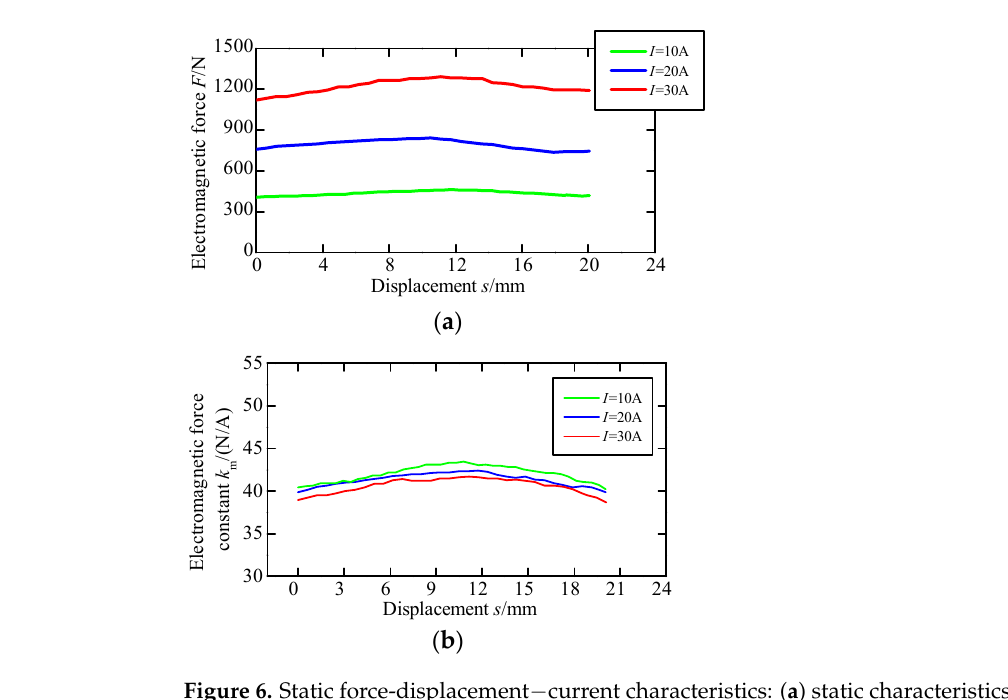
Figure 6. Static force-displacement − current characteristics: ( a ) static characteristics among current, displacement and electromagnetic force; and ( b ) static characteristics among current, displacement and electromagnetic force constant.